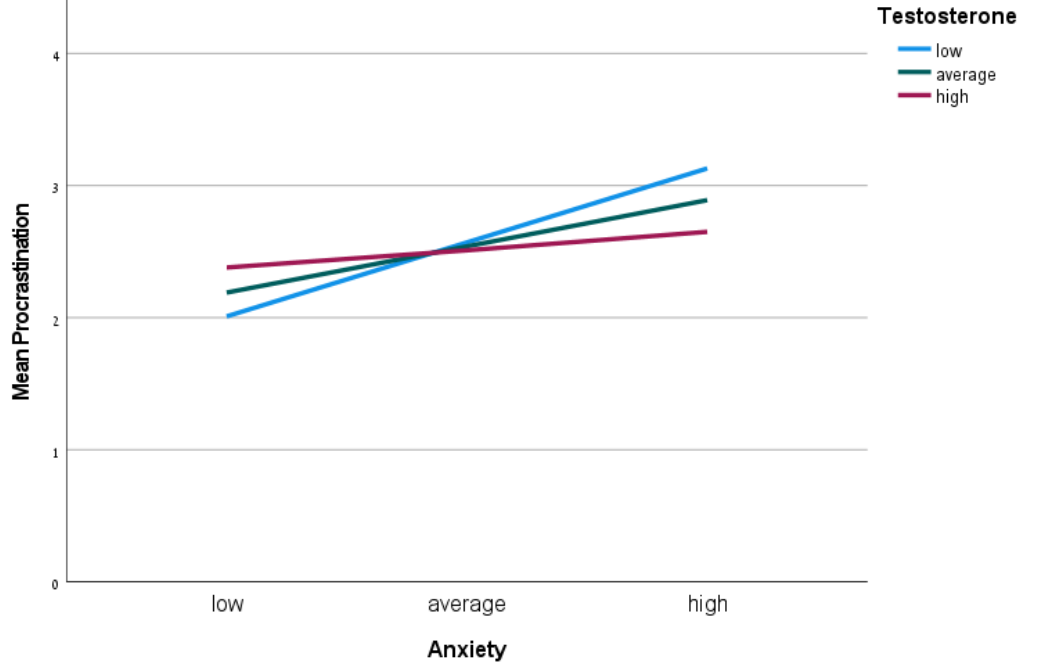
Figure 1. T × anxiety interaction for procrastination. A significant positive relationship between anxiety and procrastination (mean procrastination refers to the average score on the General Procrastination Scale [GPS]) is only found at low (blue line) and average (red line) testosterone levels. Note: Plotted points represent conditional low, average, and high values ( ± 1 SDs) of testosterone and state anxiety.